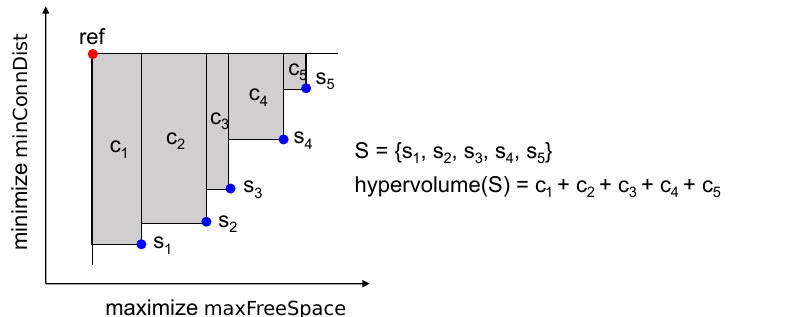
Figure 4. Illustration of the hypervolume calculation for a set of non-dominated solutions S, given the maximization objective maxFreeSpace and minimization objective minConnDist